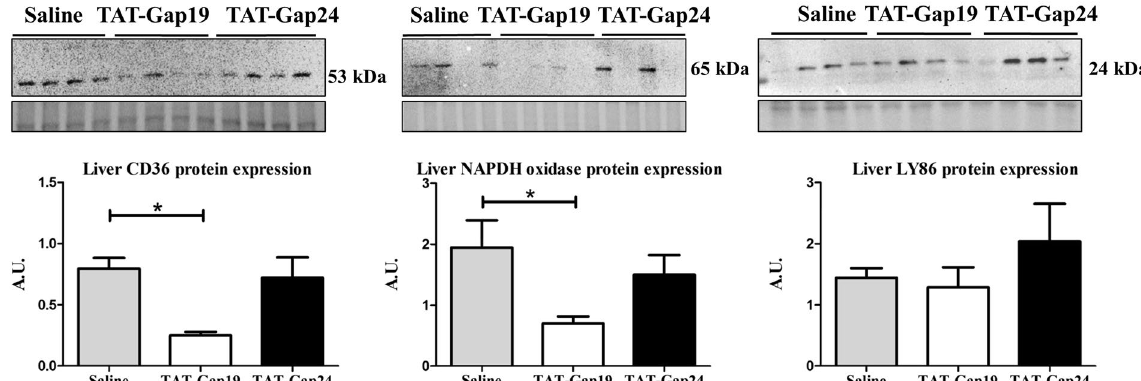
Figure 6. Protein expression analysis of liver tissue of TAT-Gap24 and TAT-Gap19-treated NASH animals. After 8 weeks of CHFD, an osmotic pump was surgically implanted in the abdominal cavity, which ensured sustained release of 1 mg/kg/day TAT-Gap24 (n = 6) or TAT-Gap19 (n = 8) or saline (n = 9) for another 2 weeks while continuing the diet. Immunoblot analysis of CD36 (53 kDa), NADPH oxidase (65 kDa) and LY86 (24 kDa) after separation and blotting, after which results were normalized to total protein. Blot images are cropped. Full- length blots are presented in Supplementary Fig. 5. Data are expressed as means ± SEM with * p <